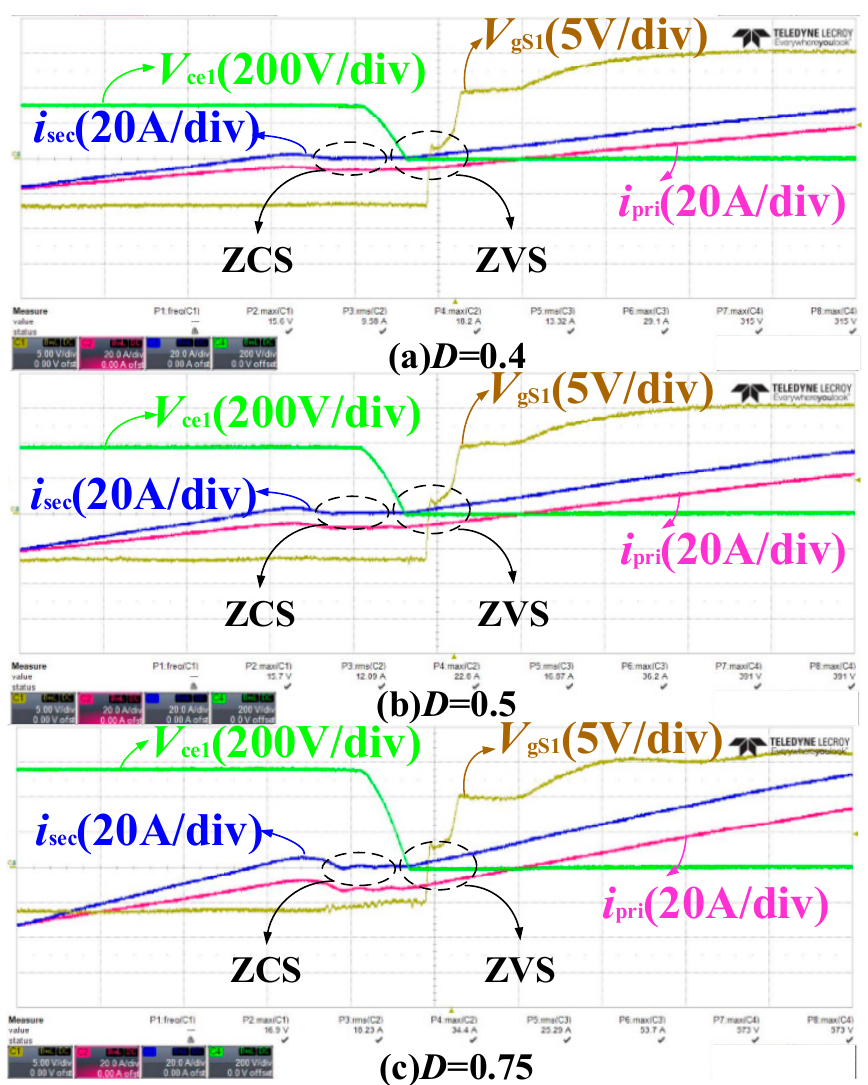
Figure 21. Back-end HFI LLC resonant converter ZVZCS characteristic curves ( a ) D = 0.4; ( b ) D = 0.5; ( c ) D = 0.75.